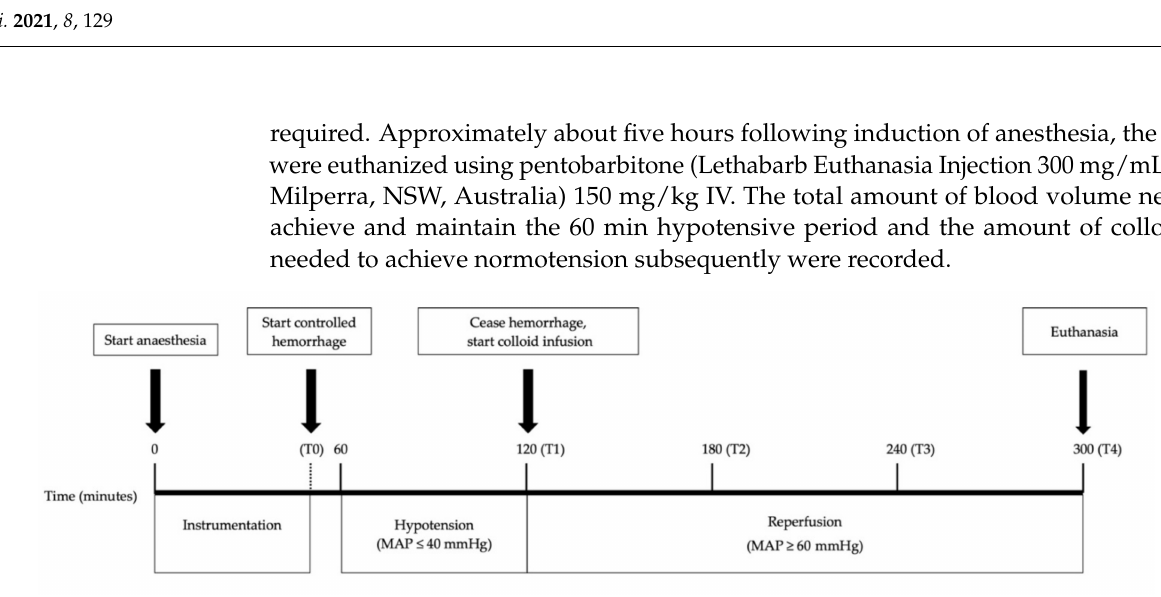
Figure 1. Timeline of the pressure-targeted hemorrhage model performed in 12 adult male Greyhounds. MAP = mean arterial pressure. T0–T4 were time points at which cardiac output was measured, and blood (arterial and venous) and urine samples were collected.